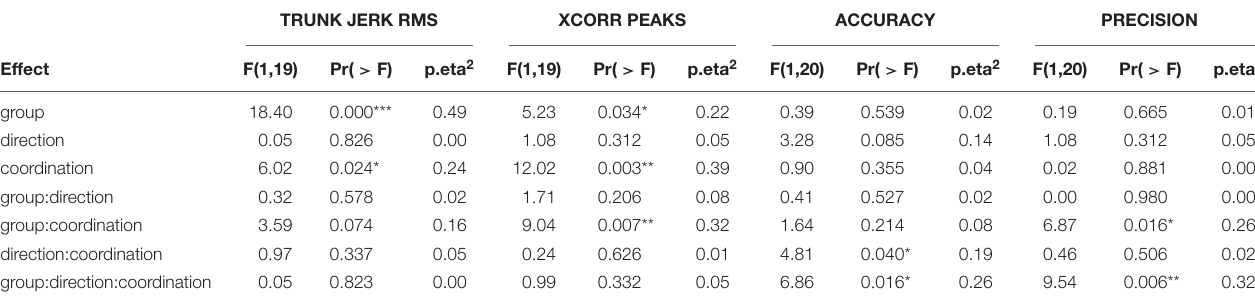
TABLE 2 | Results of the ANOVA tests for each of the four computed measures. TRUNK JERK RMS XCORR PEAKS ACCURACY PRECISION